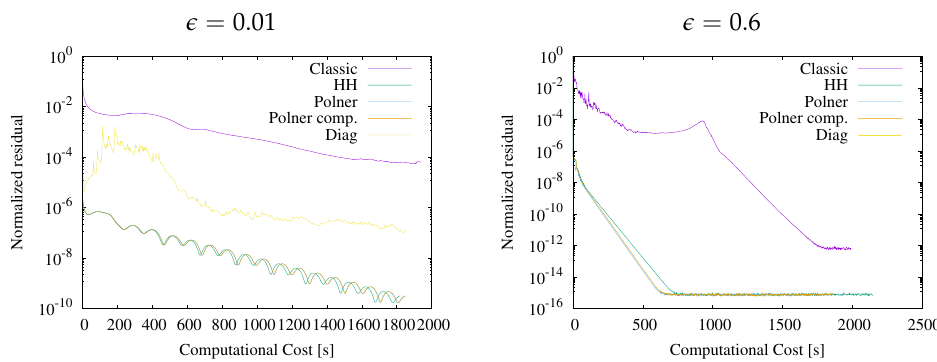
Figure 2. Buoyancy-driven square cavity. Full Navier–Stokes equations. Residual convergence for various stabilization matrices